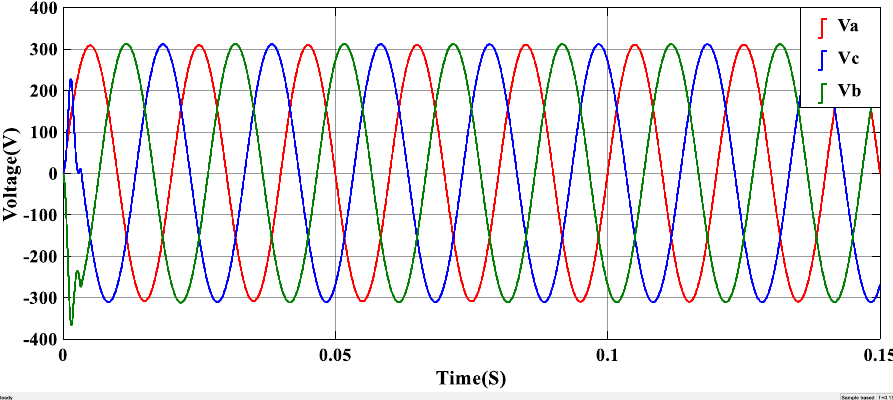
Figure 14. A three-phase output voltage waveform of the inverter.